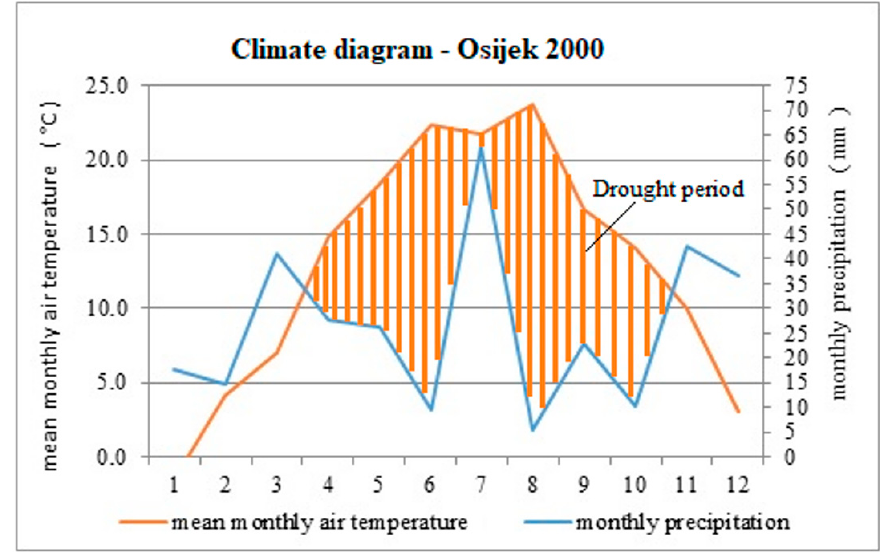
Figure 6. Climate diagram for Osijek, Croatia for the year 2000.